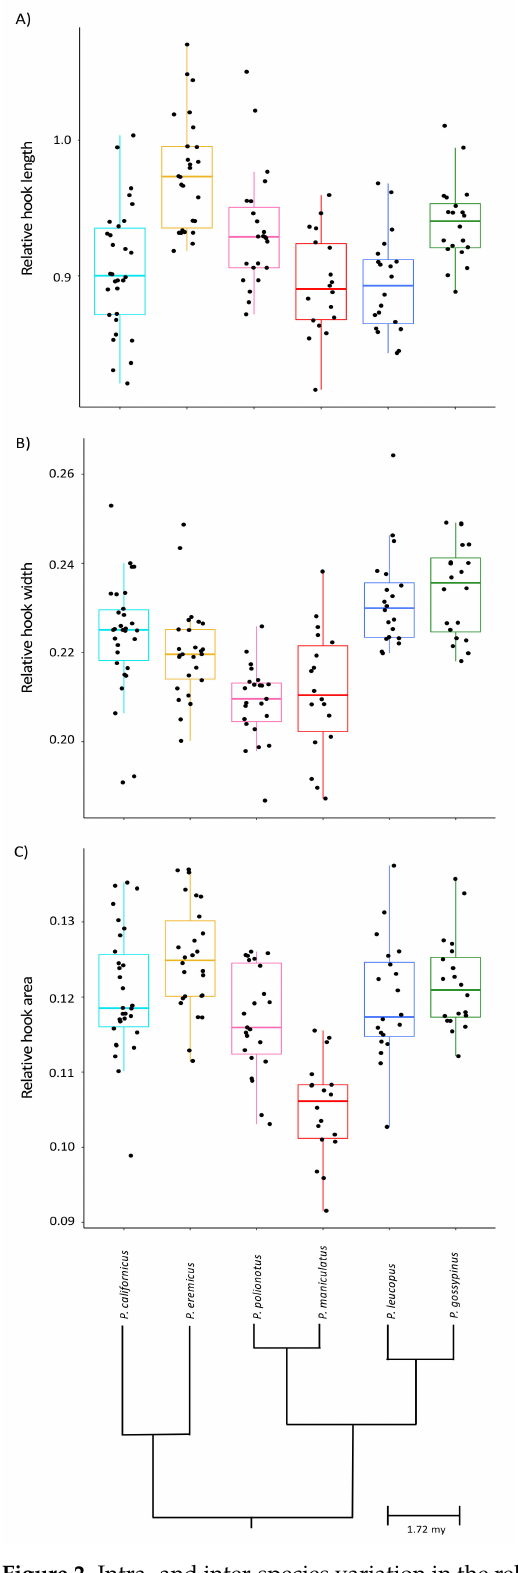
Figure 2. Intra- and inter-species variation in the relative length ( A ), width ( B ), and area ( C ) of the apical hook featured on the heads of sperm cells produced by six closely related species of Peromyscus mice. Values are relative to the length, width, and area of the sperm head, respectively. Boxplots represent median and interquartile ranges with mean values per male overlaid as black dots. Species relationships are indicated within the phylogeny. Note truncated